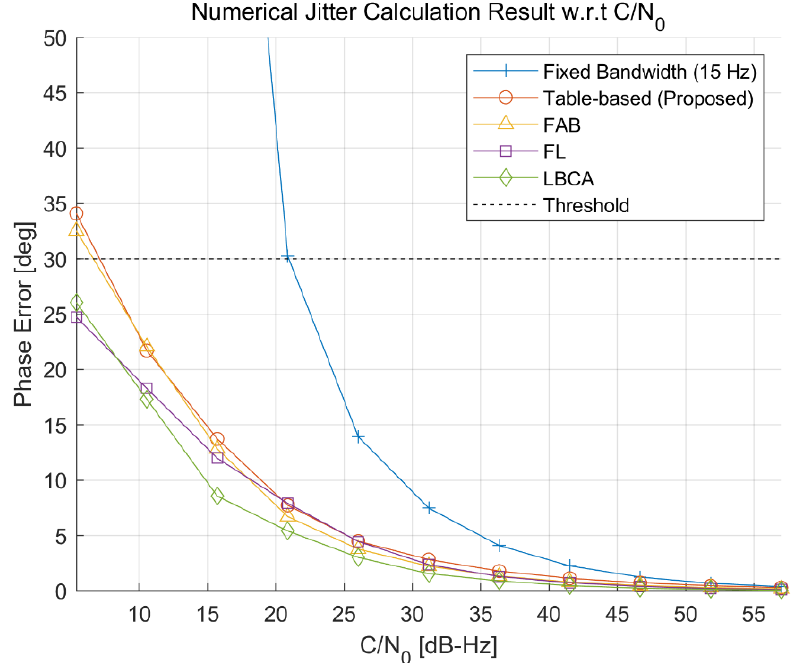
Figure 16. Numerical jitter calculation result with respect to the C/N 0 . The proposed algorithm has a similar performance to the fast adaptive bandwidth (FAB). Fuzzy logic (FL) and loop-bandwidth control algorithm (LBCA) have slightly better performances.